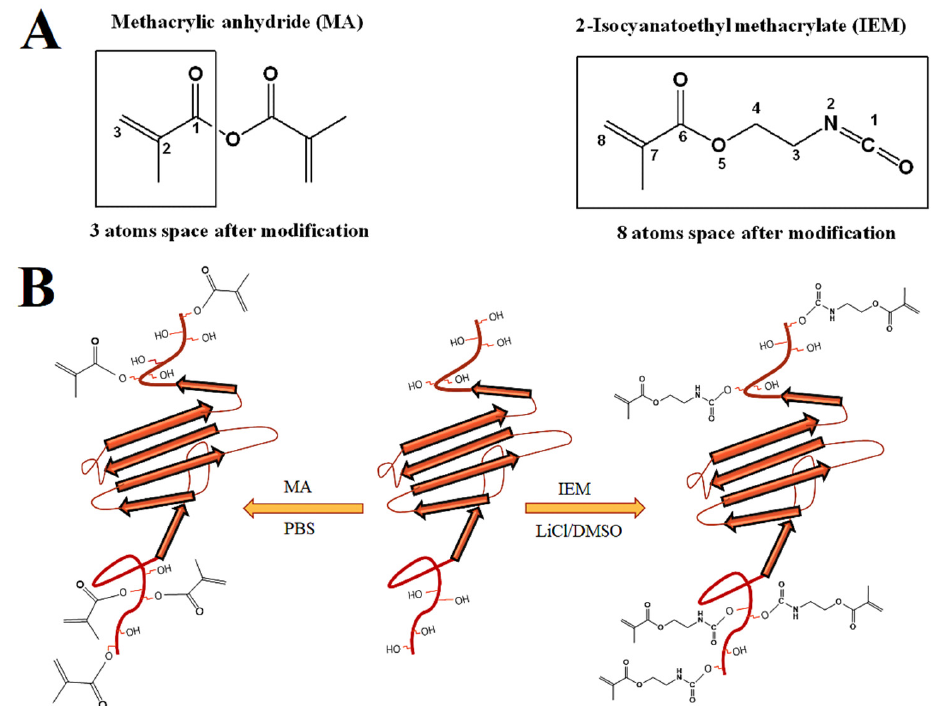
Figure 1. ( A ) Chemical structure of methacrylic anhydride (MA) and isocyanatoethyl methacrylate (IEM) showing the three- and eight-atom linkers after modification, respectively. ( B ) Modification of sericin through its hydroxyl groups with MA in PBS and with IEM in DMSO with LiCl as the catalyst to form hydrogels through